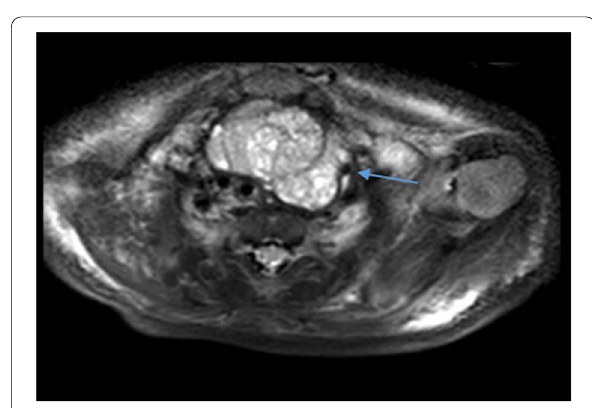
Fig. 3 Fat-suppressed T2-weighted axial MR images, heterogenous, hyperintense